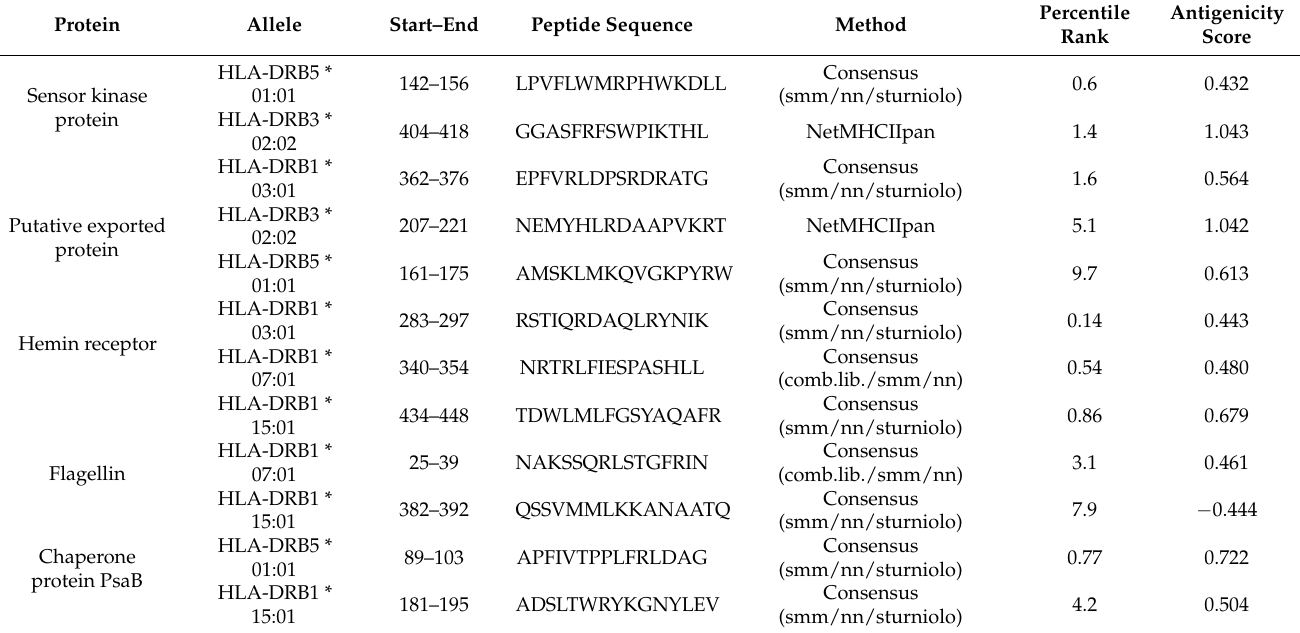
Table 3. Helper T lymphocyte (HTL) epitopes predicted by the IEDB MHC 2 server, along with their percentile ranks, alleles, peptide sequences, and antigenicity scores predicted by the AlgPred